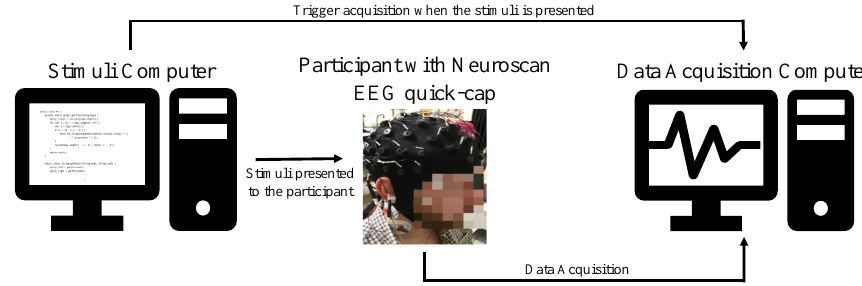
Figure 3. Schematic representation of the acquisition